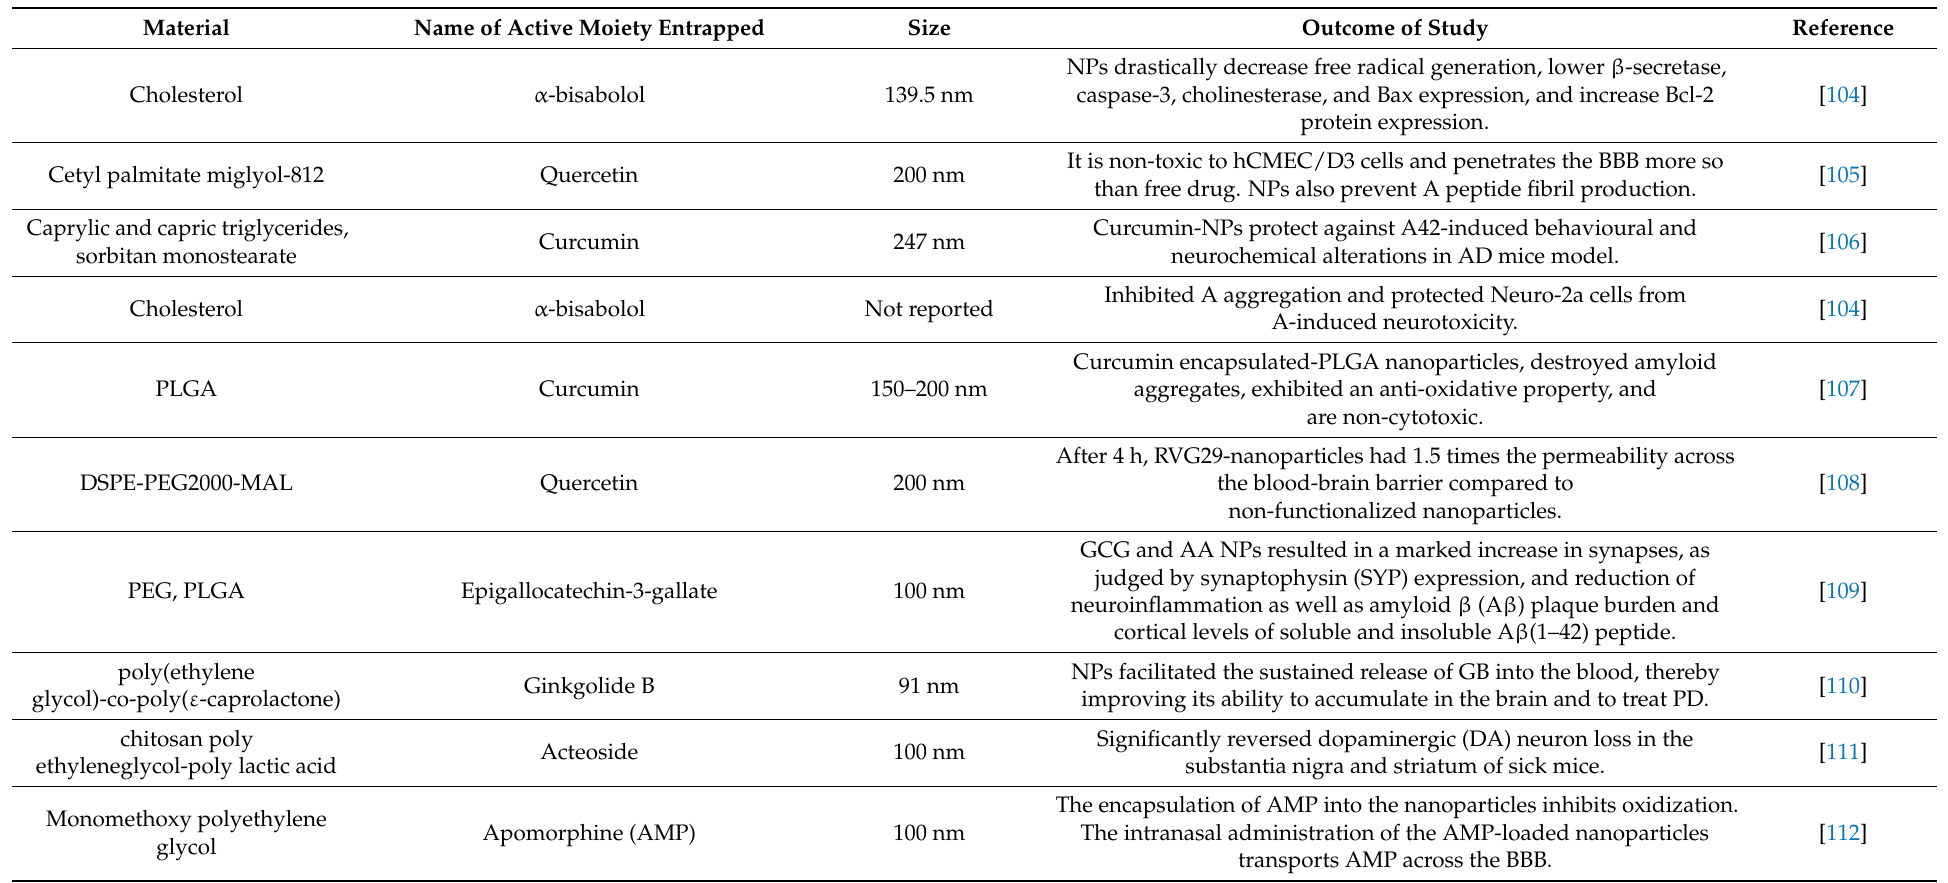
Table 2. Summary of the materials used, active moiety entrapped, and outcomes obtained upon administration of